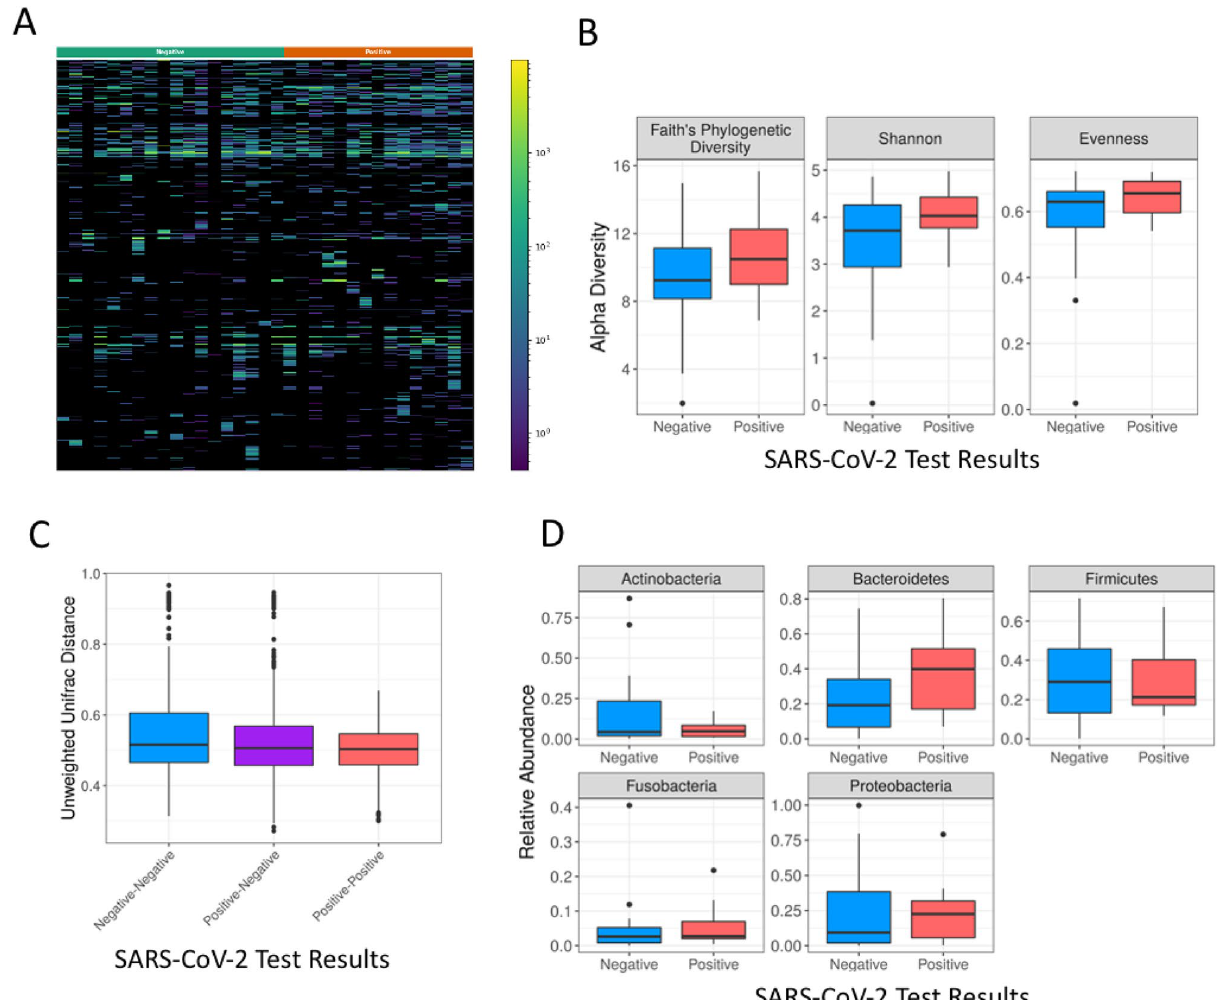
Figure 3. SARS-CoV-2 test result does not seem to have a strong effect on the nasopharyngeal microbial composition. ( A ) Heatmap showing all observed ASVs using the first sample from each subject. Each row represents a different ASV and each column a different sample. SARS-CoV-2 test results are noted in the color bar above (green for negative and orange for positive). ( B ) Boxplots of alpha diversity values, using the first sample from each subject, by SARS-CoV-2 test result. Three different alpha diversity measures were used— Faith’s phylogenetic diversity, Shannon, and evenness, as indicated. There were no significant differences in any of the measures tested ( p value > 0.1). ( C ) Boxplot of unweighted unifrac distances between positive-positive, negative-negative and positive–negative sample pairs, using only the first sample per subject. No significant difference was detected, (PERMANOVA p value of 0.21). ( D ) Boxplots of the relative abundance of the five most abundant phyla by SARS-CoV-2 test result, using only the first sample per subject (Wilcoxon rank sum test p value >